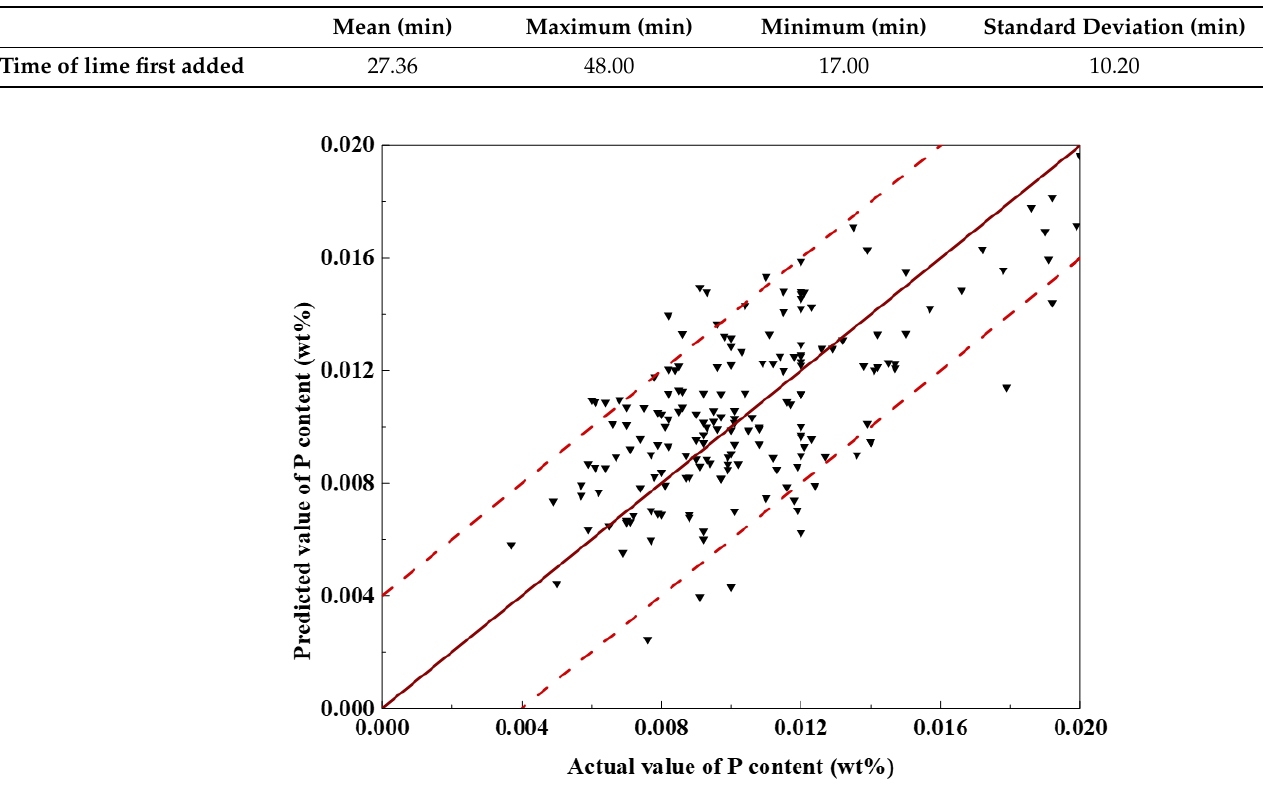
±0.005 Figure 11. Frequency of absolute deviation in the prediction model optimized with time of the first addition of lime. In Figure 10, the predicted data are evenly distributed in the space between two im- aginary lines. Compared with previous results, the predicted value and actual value show a further similar trend. Under the absolute deviation, the model is optimized after the time of the first addition of lime. Figure 10 indicates that the absolute deviation of the model is 33.89%, 50%, 75.56%, 87.78%, and 95.56% when the predictive errors are within ±0.001 (wt%), ±0.002 (wt%), ±0.003 (wt%), ±0.004 (wt%), and ±0.005 (wt%), respectively. In all the ranges of error, the improvements in frequency appear to be in accordance with the results previously obtained. In particular, the frequency when the error is within ±0.004 (wt%) is improved from 81.11% to 87.78%.